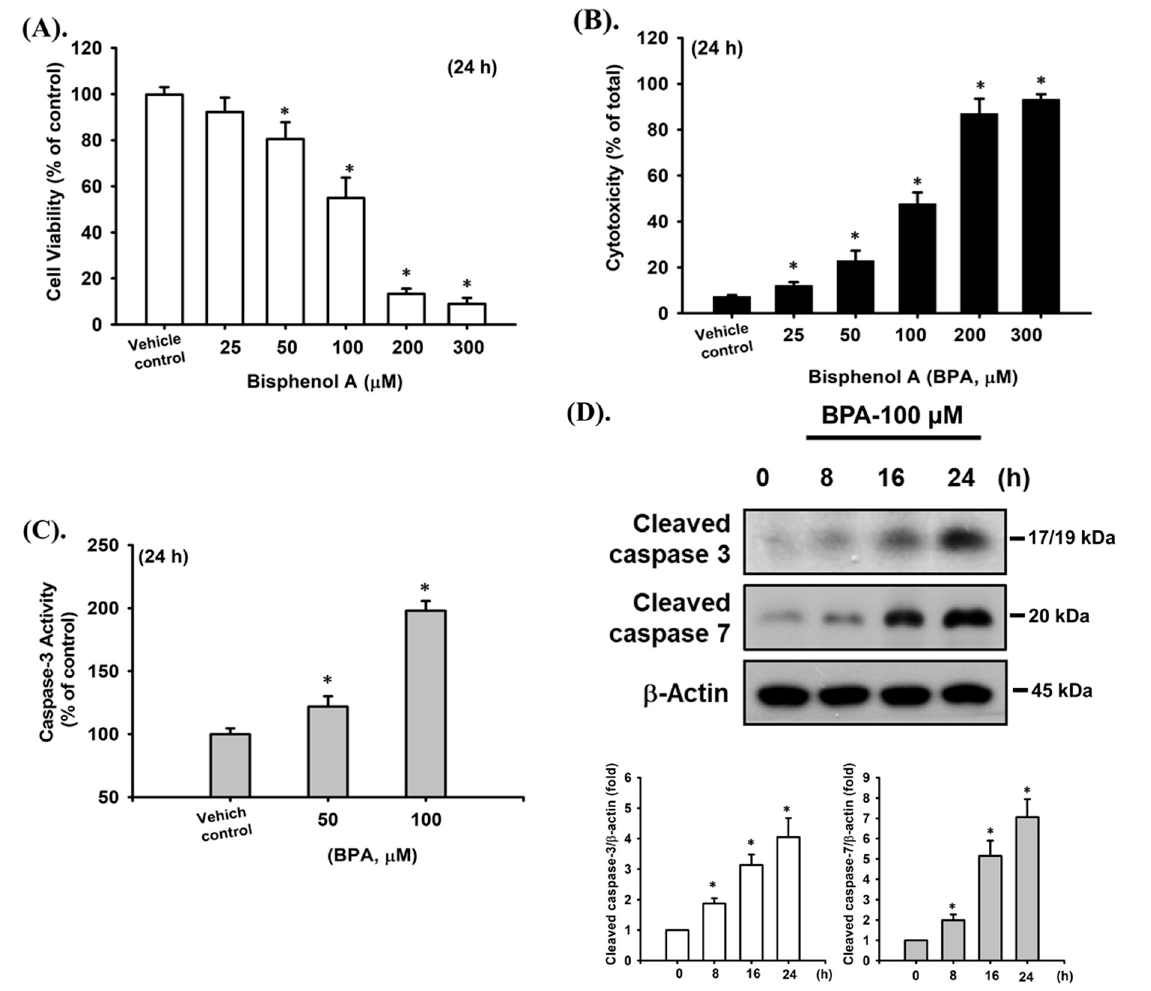
Figure 1. BPA-induced cytotoxicity and apoptosis in RIN-m5F cells. Cells were treated with BPA (0–300 μ M) for 24 h. ( A ) Cell viability was detected using the MTT assay. ( B ) Cytotoxicity was determined using the LDH release assay. ( C ) Caspase-3 activity was determined using the caspase-3 activity fluorometric assay kit. ( D ) The protein expression of cleaved caspase-3 and -7 was examined using Western blot analysis, and the quantification was performed using densitometric analysis. Data are presented as the mean ± S.D. of four independent experiments assayed in triplicate. * p < 0.05 compared to the vehicle control.